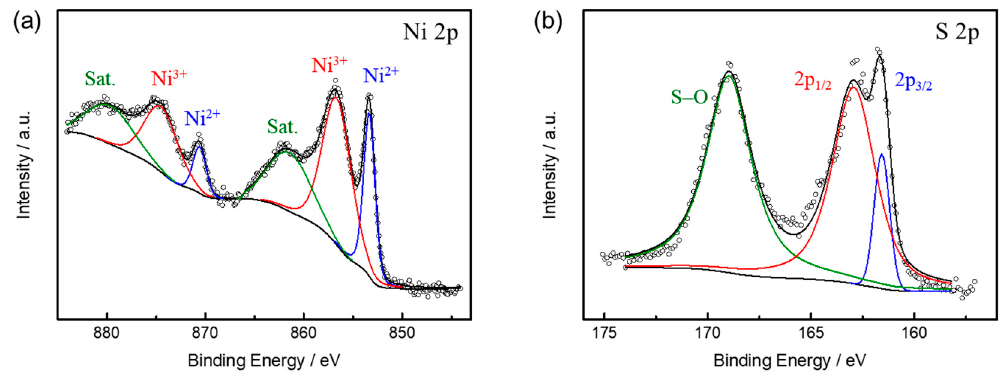
Figure 3. High-resolution XPS ( a ) Ni 2p and ( b ) S 2p spectra of NiS.